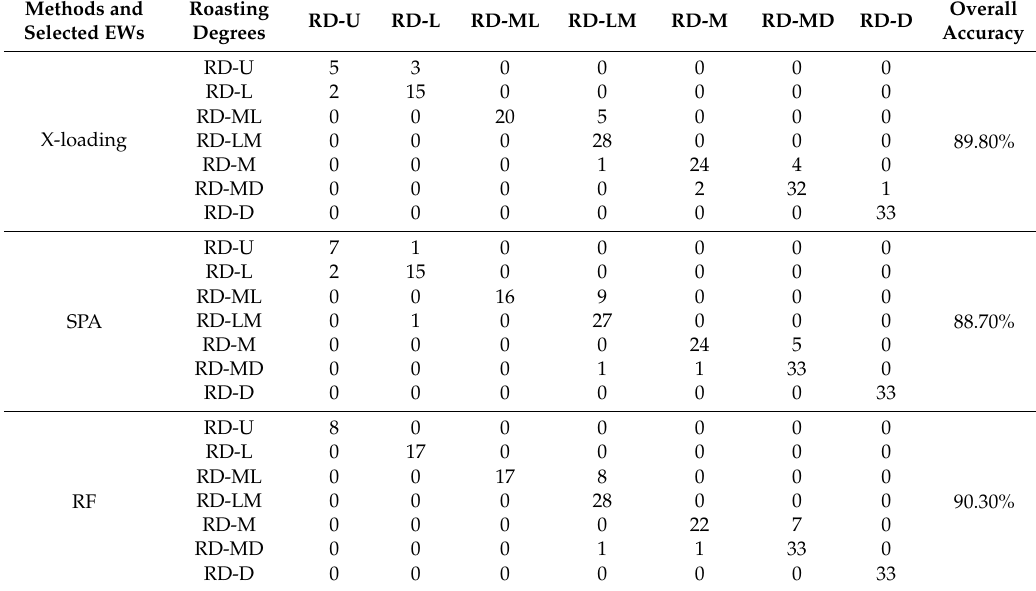
Table 3. Results of least squares support vector machine (LS-SVM) determinative models for differentiating between the roasting degrees of the coffee beans in the prediction set using different methods for selecting the